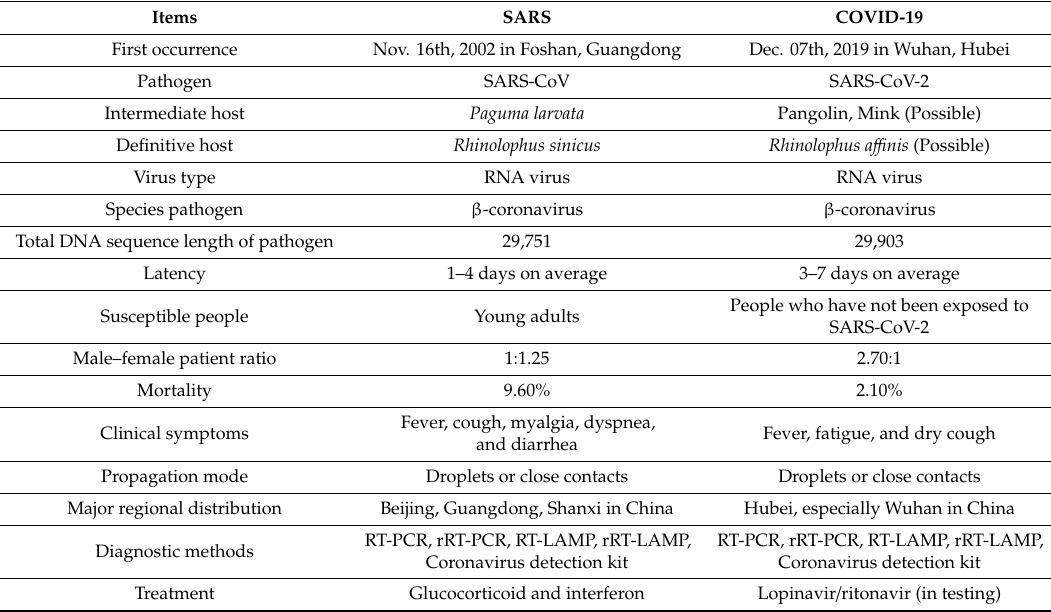
Table 1. Comparison of SARS and